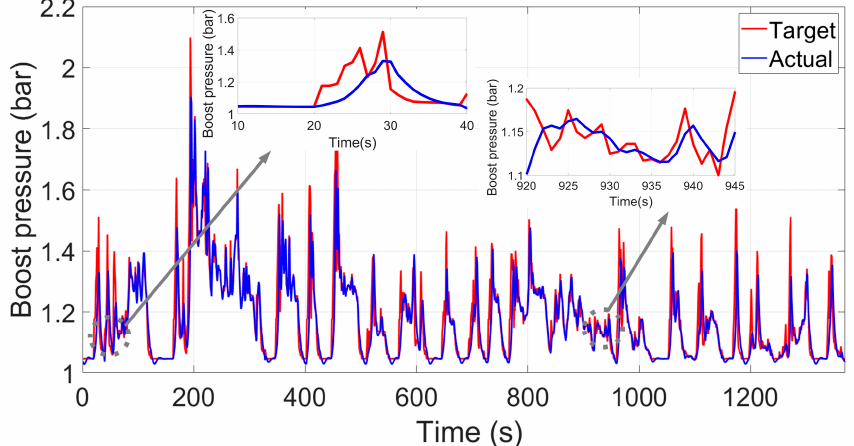
Figure 12. The fine-tuned gain-scheduled PID control performance. Processes 2019, 7, 601